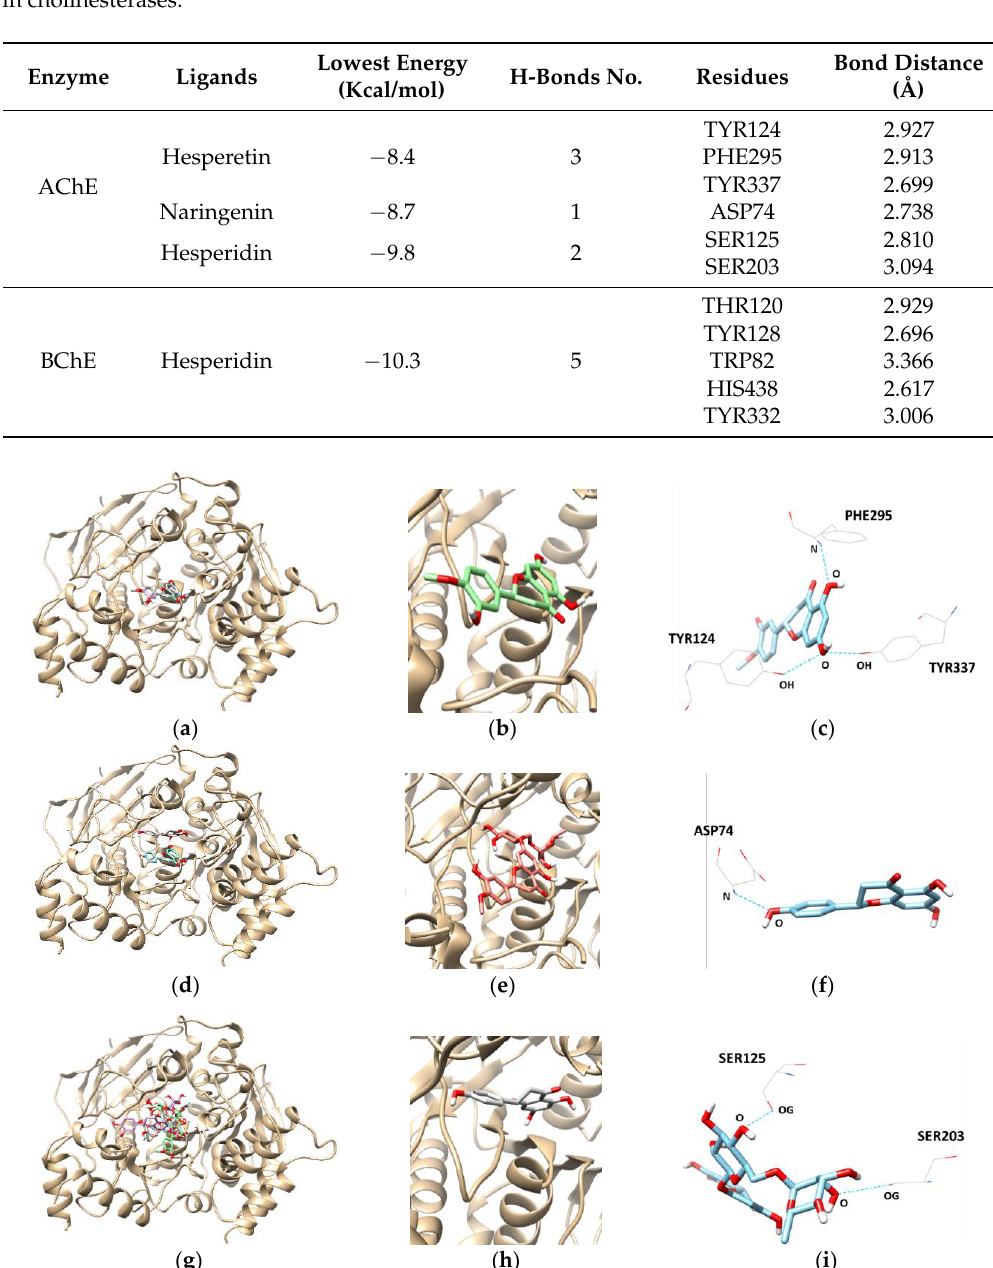
Table 4. Lowest energies and the number of hydrogen bond interactions of citrus flavanones in cholinesterases.